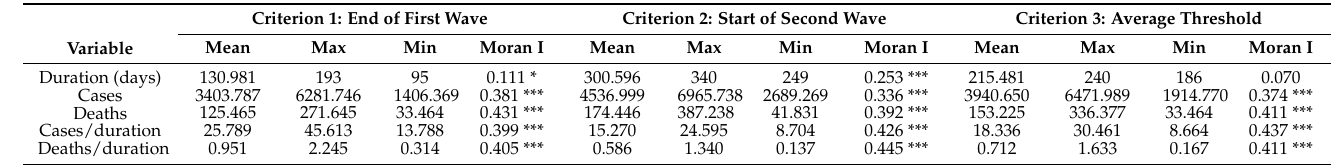
Table 1. Wave 1 statistics using different